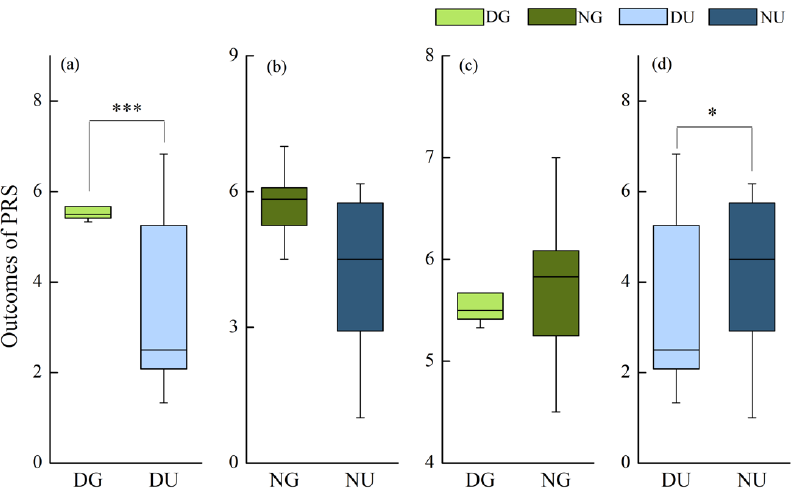
Figure 8. Restorative outcomes of Perceived Restorativeness Scale (PRS) in: ( a ) daytime walking; ( b ) nighttime walking; ( c ) green walking; and ( d ) urban walking. The * represents p < 0.05, and *** represents p < 0.001. Compared using Post Hoc Multiple comparisons (LSD method) ( N = 12).